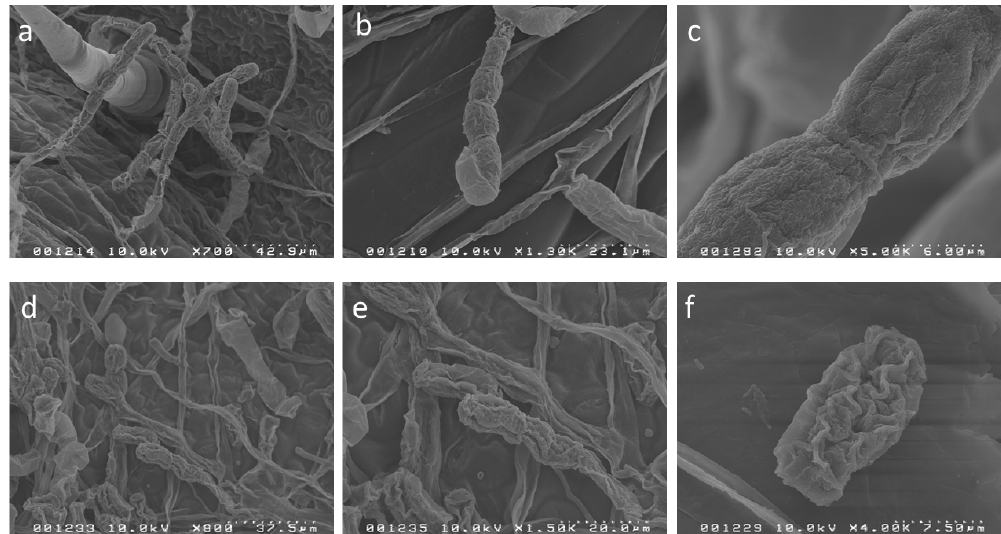
Figure 7. Scanning electron micrograph of hyphae and conidia of S. fuliginea of control untreated infected cucumber leaves: ( a ) at low magnification; ( b ) at high magnification; ( c ) normal with a complete smooth surface of the conidium at high magnification; ( d – f ) infected leaves exposed to a single application of Timorex Gold. Note alterations in hyphal morphology and shriveling and conidial destruction at low ( d ) and high ( e ) magnification and destroyed conidia at a high ( f ) magnification. Leaf samples for microscopy were taken 24 h post-application.